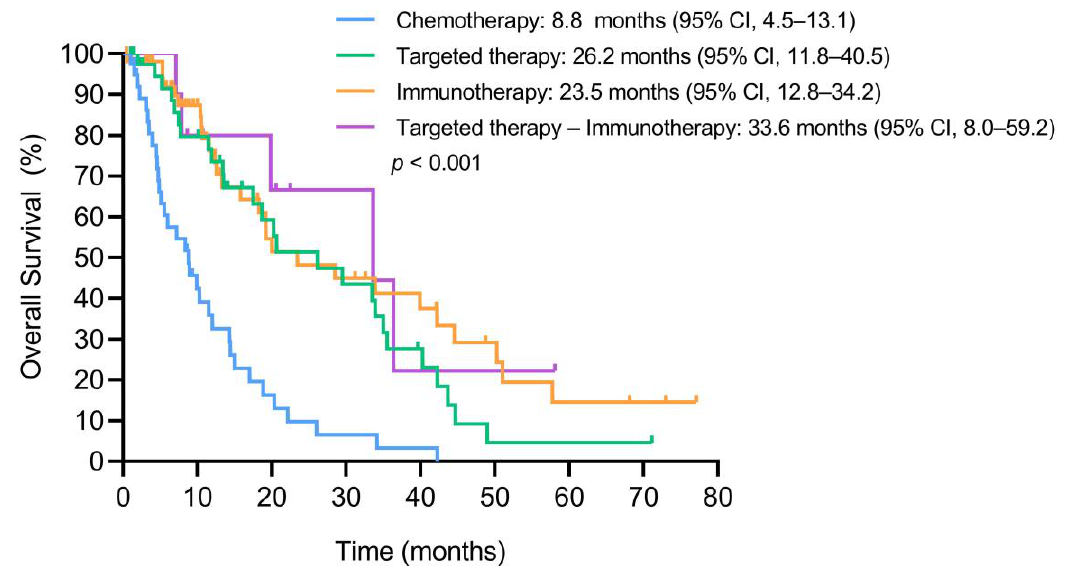
Figure 6. Overall survival of patients with stage IV NSCLC stratified by the treatment strategies administered during the course of the